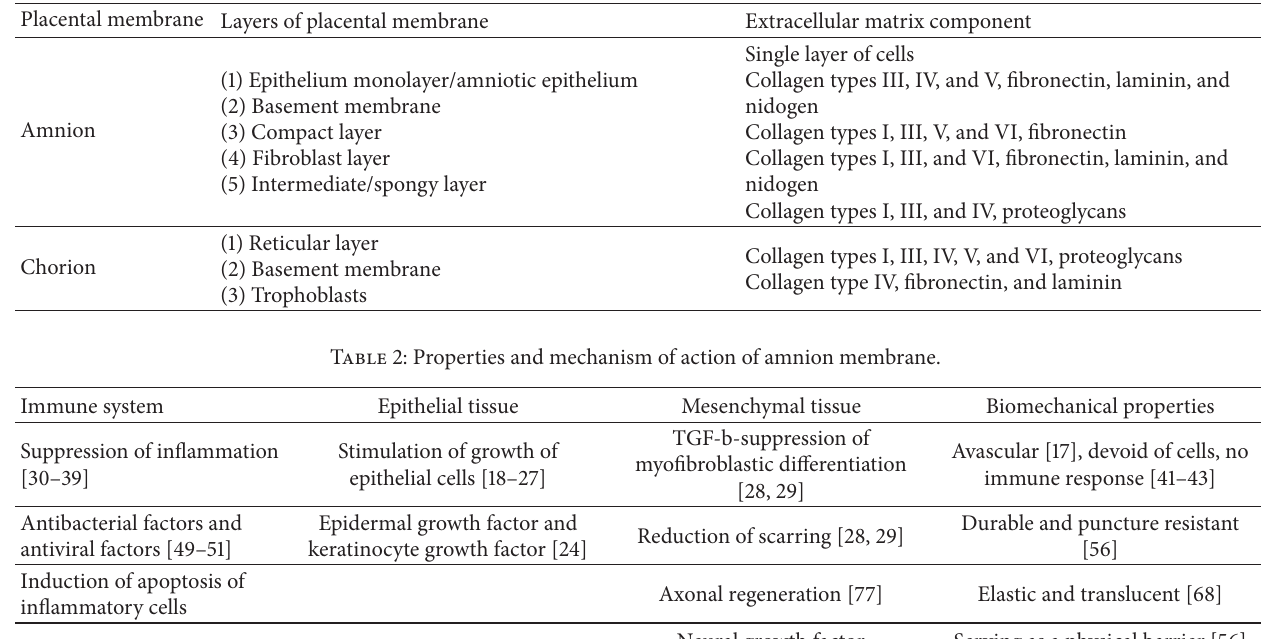
Table 1: Structure and composition of placental membranes.